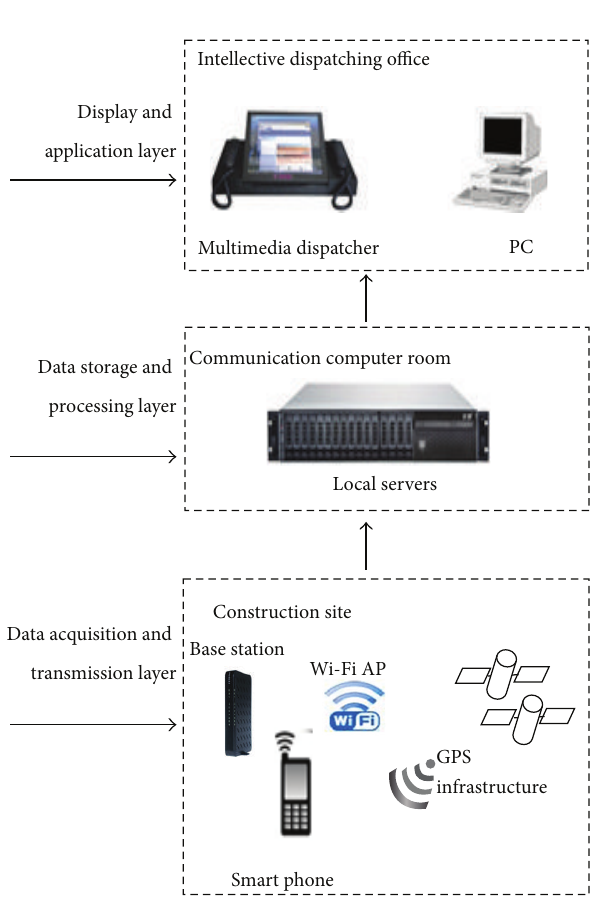
Figure 3: Block diagram of the real-time location